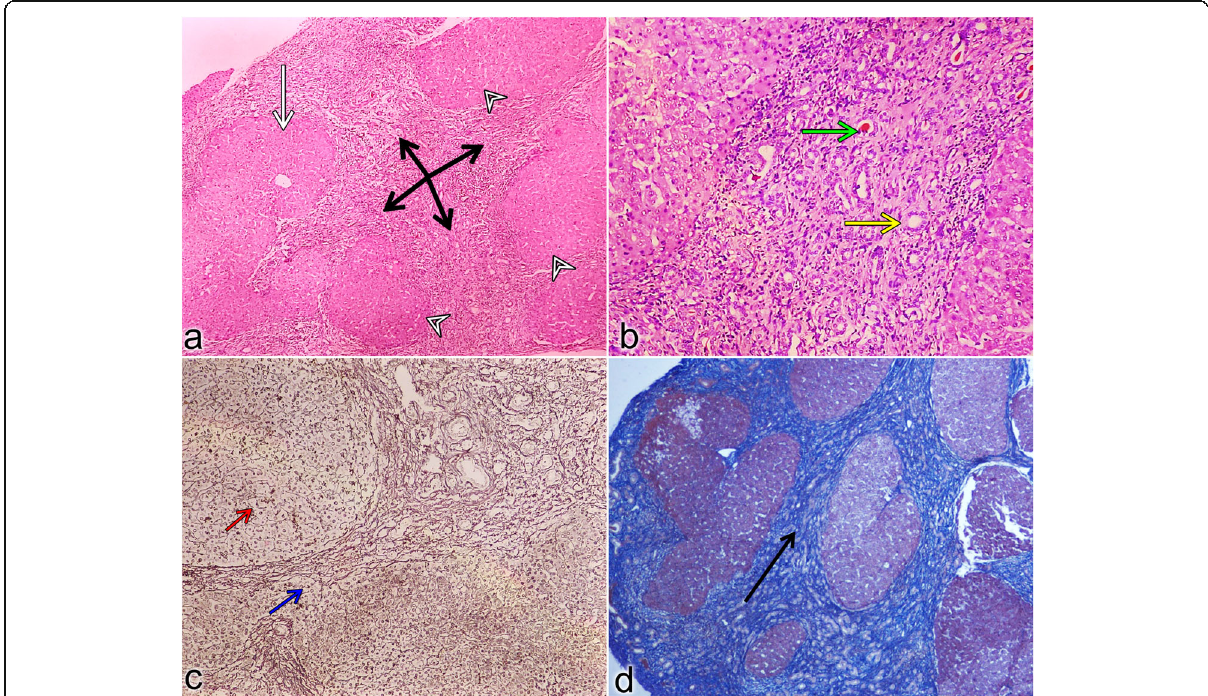
Fig. 2 Sections from the wedge biopsy of liver showing a loss of normal architecture with irregular bridging fibrosis (black arrows) separating the liver parenchyma into lobules (white arrow) and irregular nodules (white arrow heads) (H&E, × 40). b Bile ductular proliferation (yellow arrow) and bile plugging (green arrow) (H&E, × 200). c Reticulin stain has highlighted the fibrosis (blue arrow) outlining a nodule and the nodule shows maintained reticulin framework (red arrow) (reticulin stain, × 100). d Masson ’ s trichrome stain has highlighted the irregular fibrosis (black arrow)